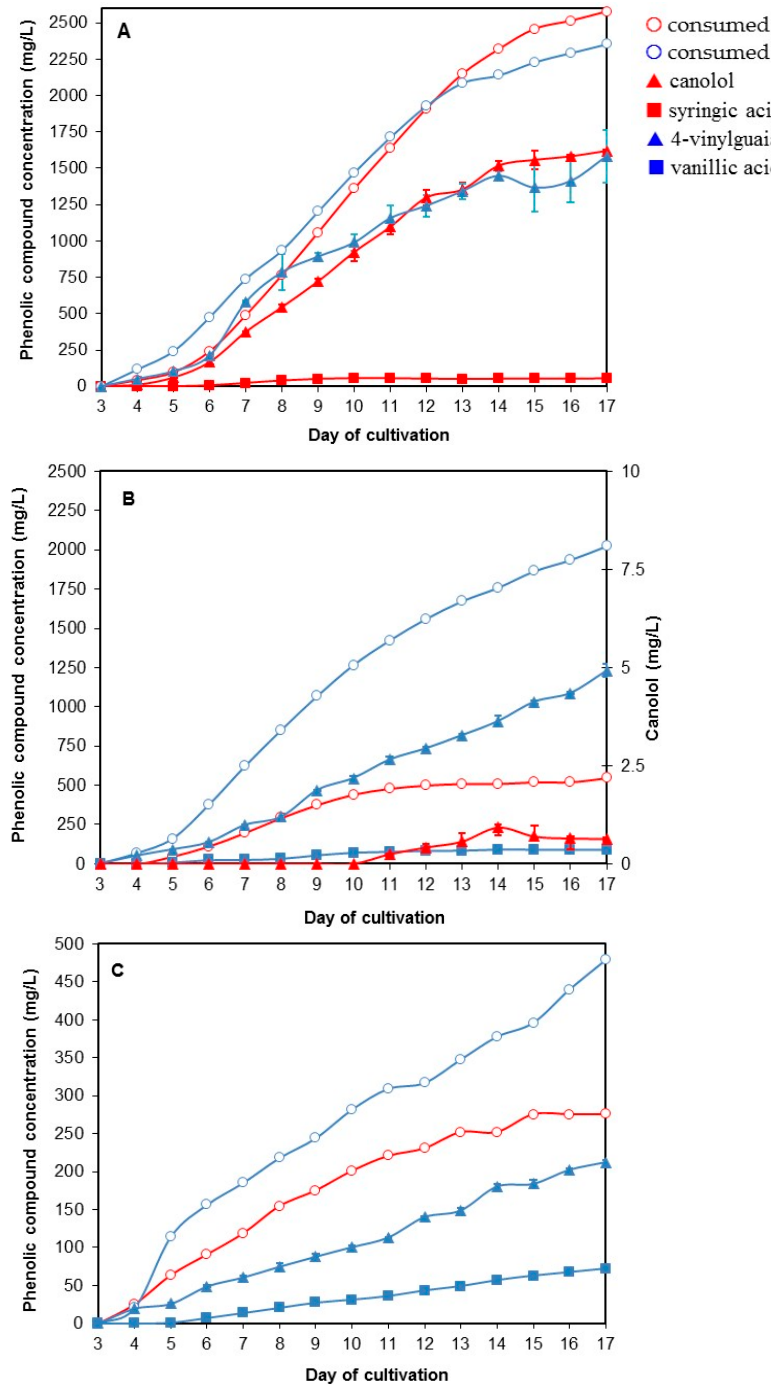
Figure 4. SA and FA metabolism by N. lepideus BRFM 15 ( A ), S. commune BRFM823 ( B ) and S. hirsutum BRFM889 ( C ): consumption of SA or FA in relation to the production of canolol and syringic acid, and VG and vanillic acid, respectively.